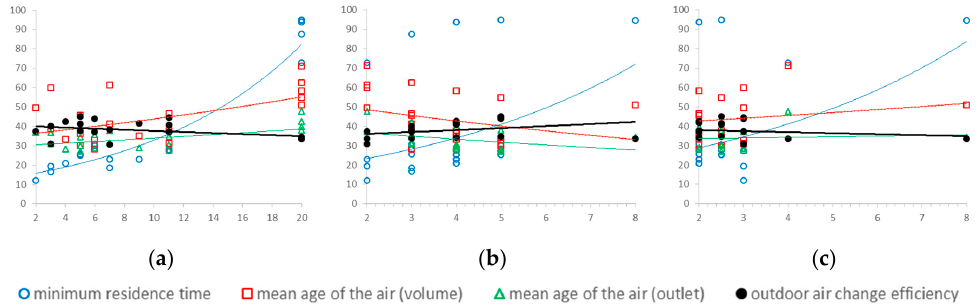
Figure 8. Trend of the results according to the dimensions of the CD. ( a ) Length (L); ( b ) width (D); ( c ) height (T). Vertical scale in meters and efficiency percentage (outdoor air change efficiency (OACE)).